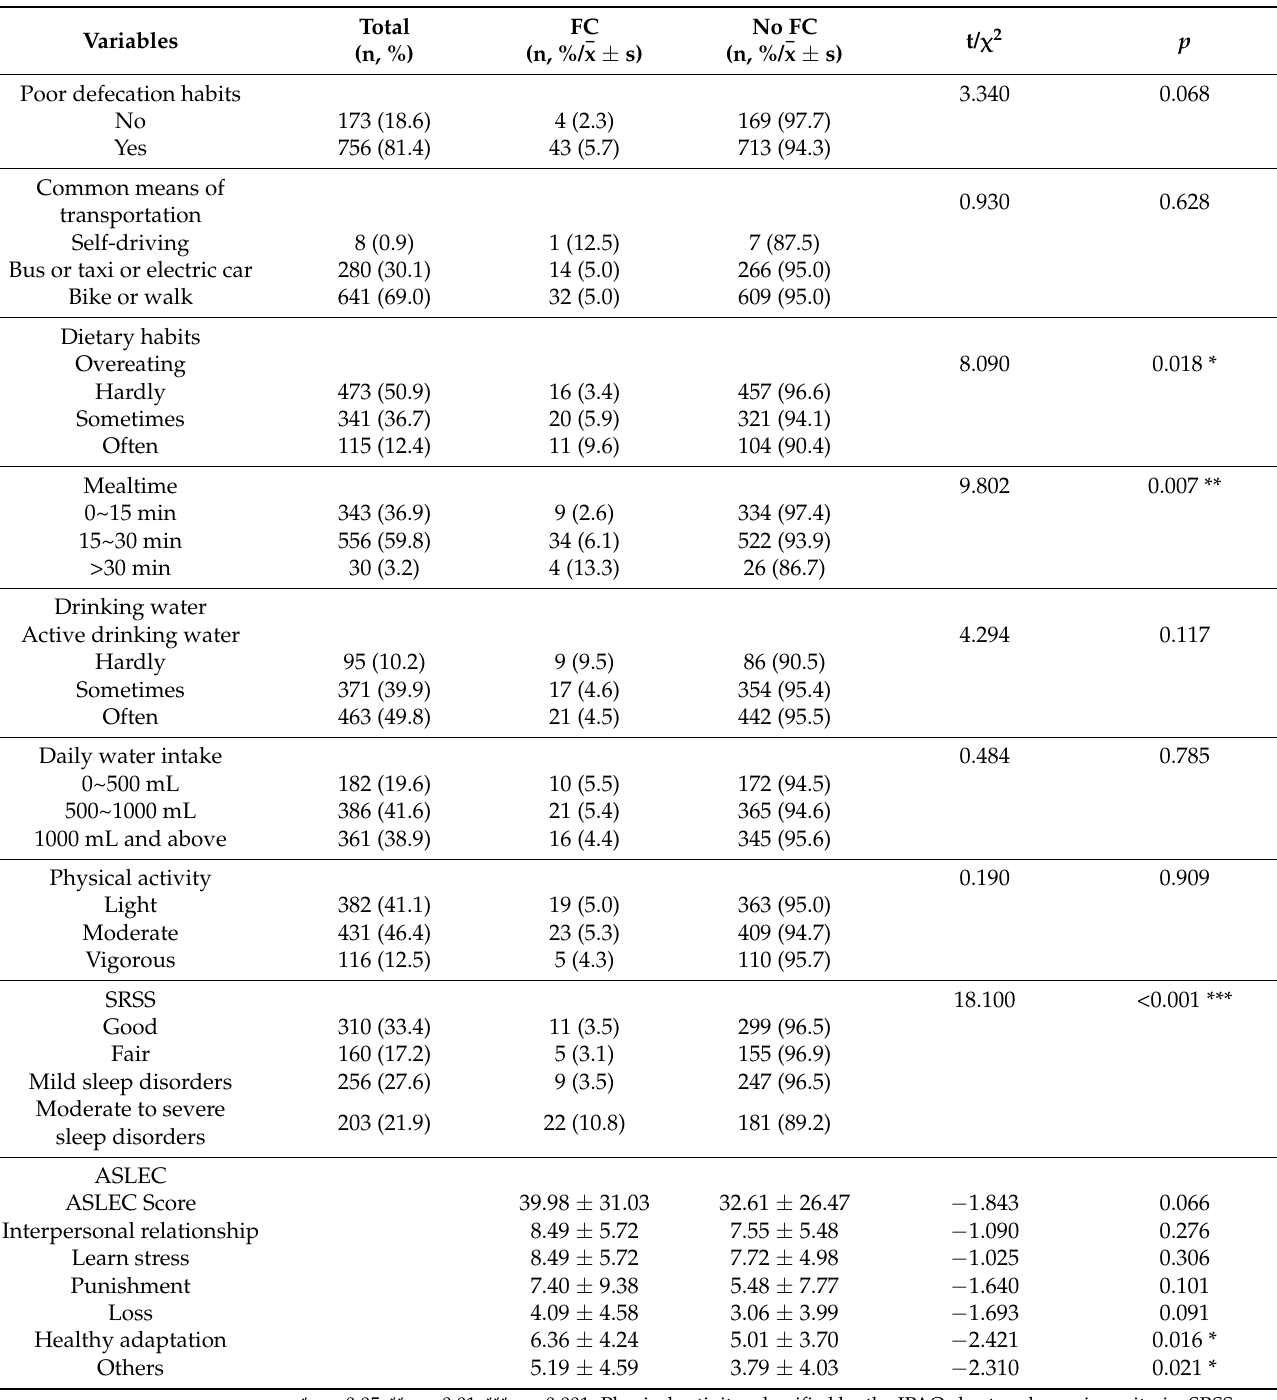
Table 2. Comparison of behavioral habits, physical activity, sleep status, and life events between university students with and without